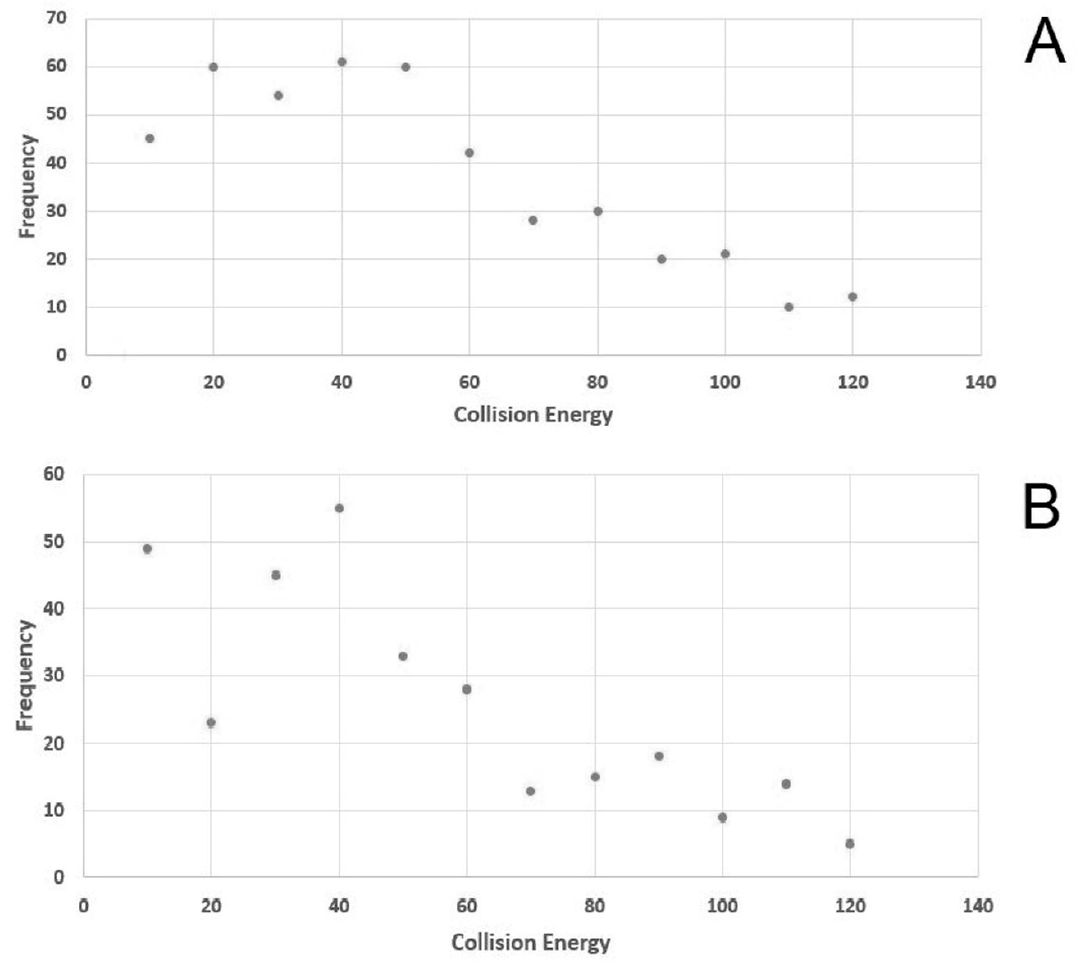
Figure 1. Figure shows in ordinates the number of molecules and in abscises the best normalized collision energy. The panel above ( A ) is show positive mode results and in panel below ( B ) in negative mode. Table 1. Chromatographic columns and mobile phases tested during method development with the reports of how many peaks fulfill chromatographic suitability criteria: symmetry, peak width and the conjunction of both. Column Positive Negative Phase Reversed Phase B—Solvent